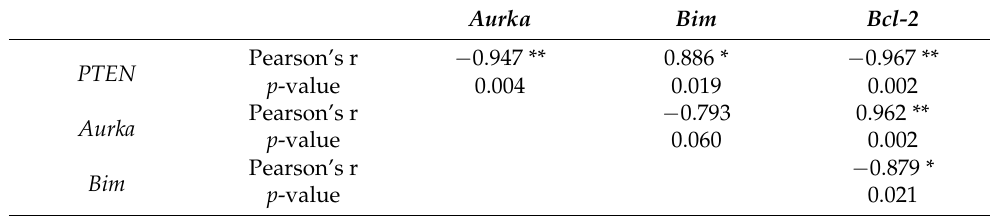
Table 3. Correlation between expressions of genes in MCF-7 cells in response to